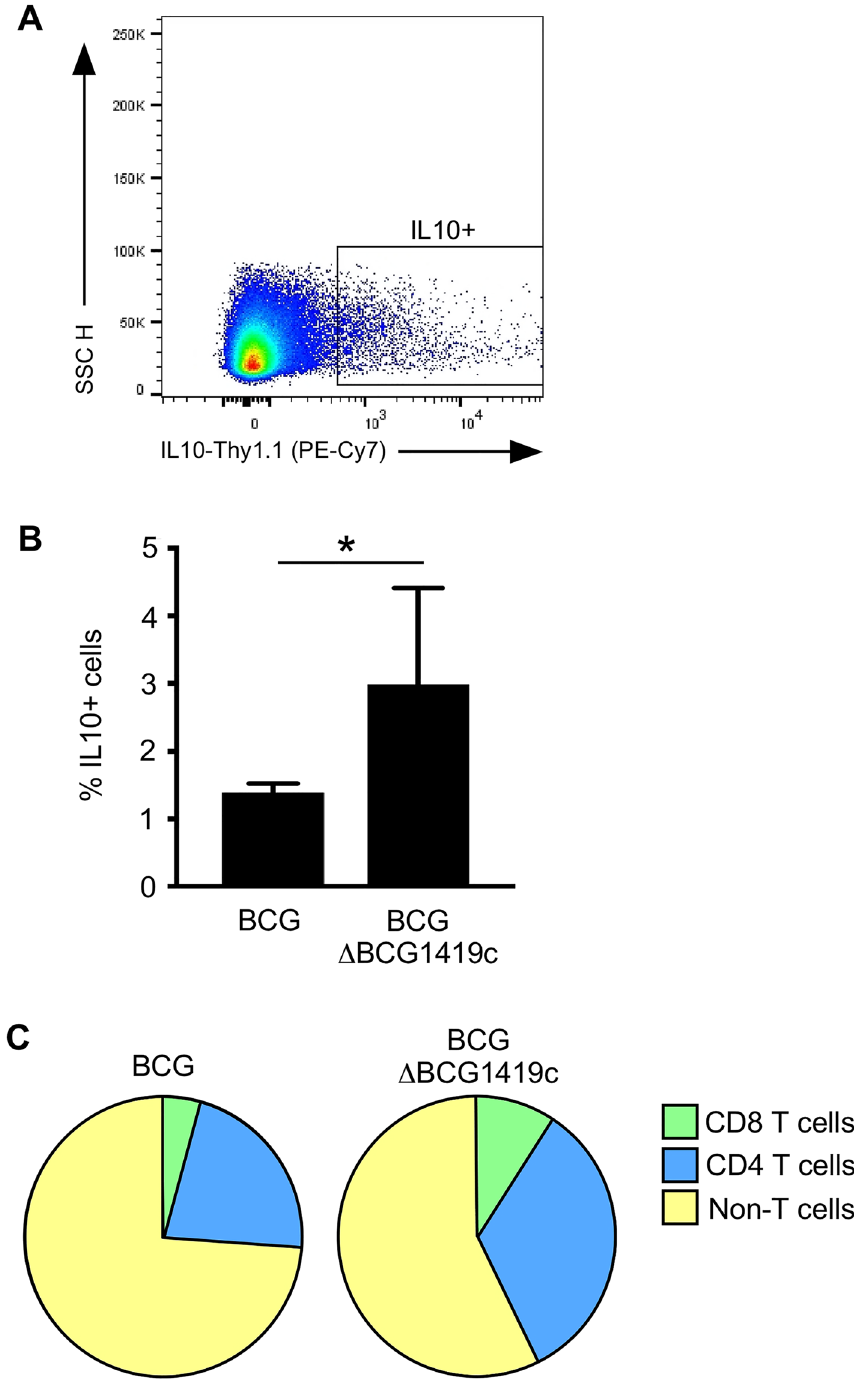
Figure 10. BCGΔBCG1419c-immunization elicits a higher frequency of IL10-producing T cells. IL10 reporter mice were s.c. immunized with 10 4 CFU of BCG or BCGΔBCG1419c; 14 days later, splenocytes from each group were stained for Thy1.1 (the transgene reporter of IL10 production) and T cell markers CD4 and CD8. Shown are ( A ) representative side scatter (SSC) and Thy1.1 staining from BCG-immunized mice, ( B ) the frequency of IL10 + splenocytes in BCG- and BCGΔBCG1419c-immunized mice (mean + SD; 3 mice per group), and ( C ) the relative proportion of IL10 + cells that are CD4 T cells, CD8 T cells or non-T cells. Asterisks represent a statistically significant difference between indicated comparison (*p ≤